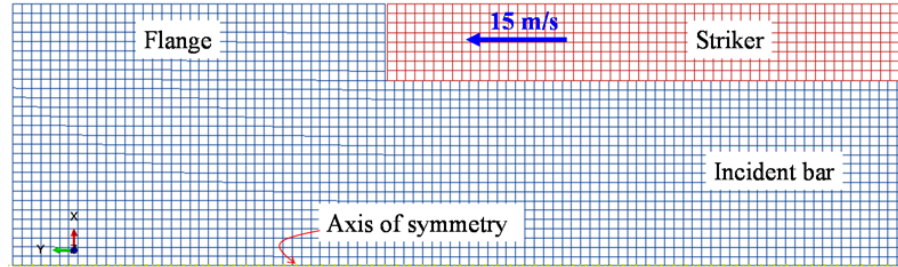
Figure 2. Finite element model near the flange structure region for the case where A s / A b = 1, A s = A f, L f = 20 mm, and D b = 20 mm.